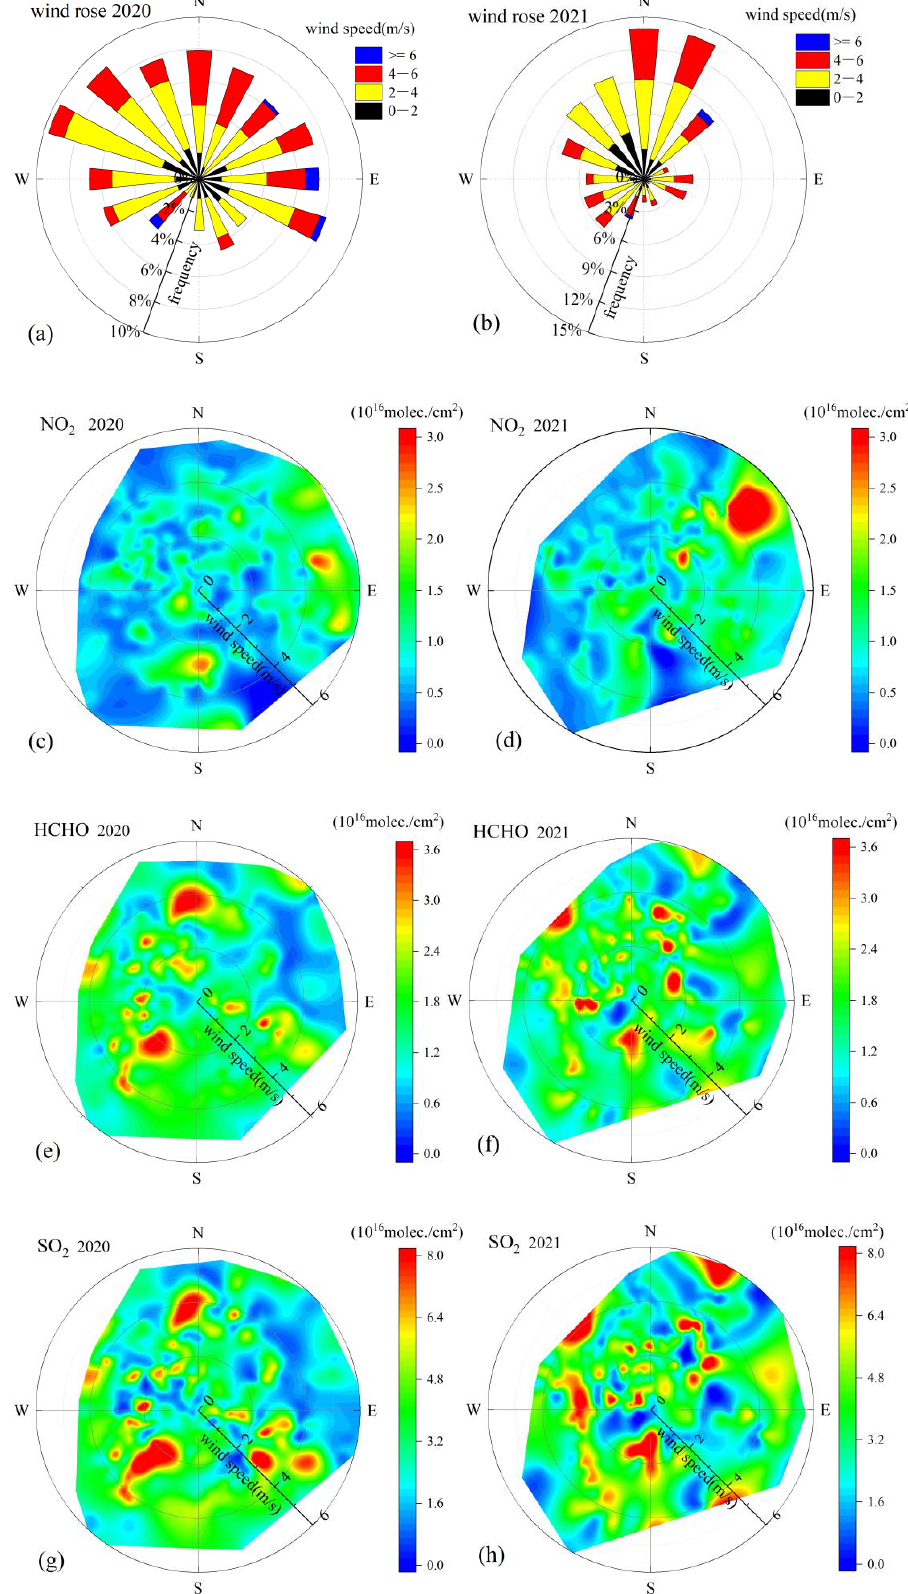
Figure 7. Wind roses in ( a ) 2020 and ( b ) 2021. Dependence of ( c , d ) NO 2 , ( e , f ) HCHO and ( g , h ) SO 2 VCDs on wind directions and wind speeds in 2020 and 2021.